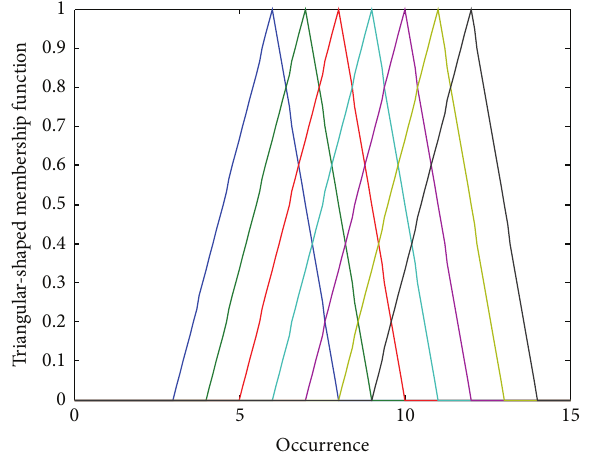
Figure 3: Triangular-shaped membership for Occurrence.